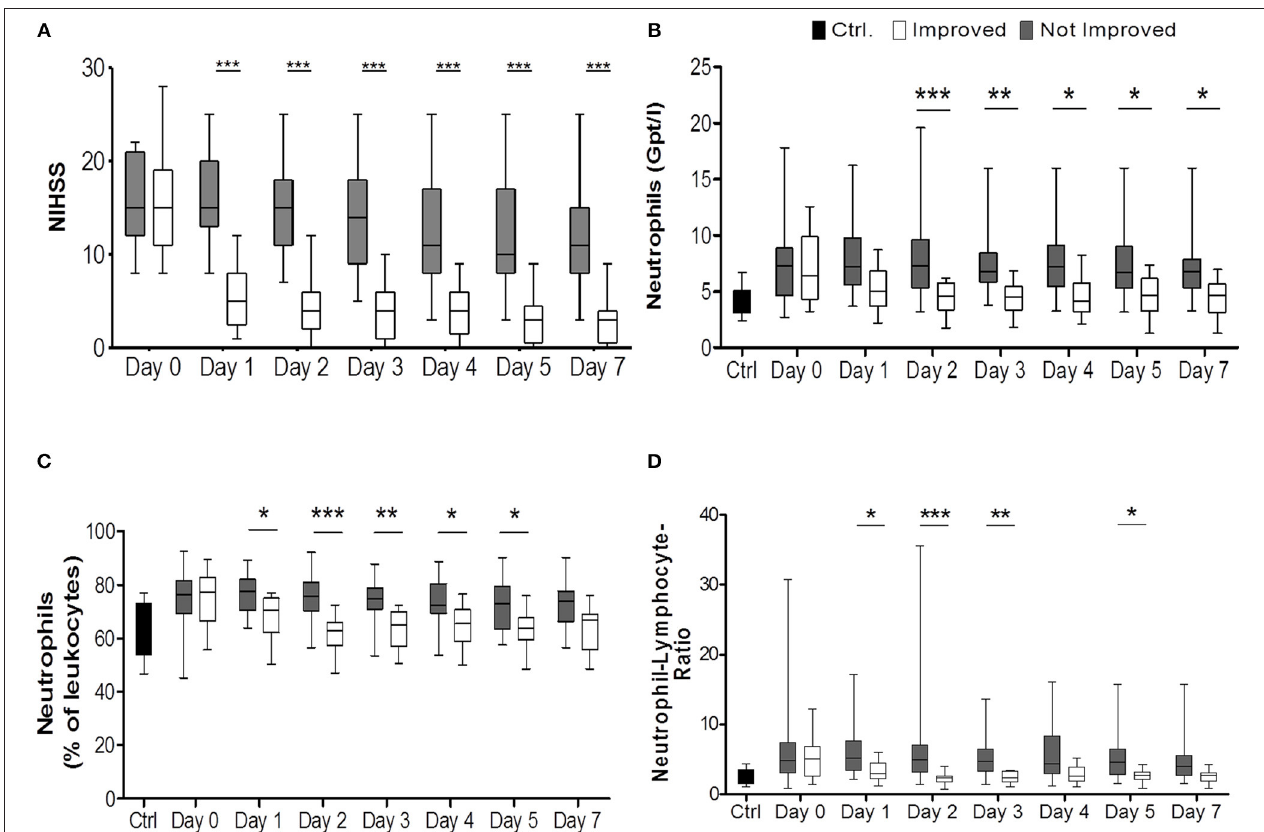
FIGURE 1 | Comparison of improved patients (white bars) vs. non-improved patients (gray bars) on the day of stroke unit admission (day 0), days 1, 2, 3, 4, 5, 7. National Institutes of Health Stroke Scale (NIHSS) served as surrogate marker for neurological improvement (A) (n imp = 13, n non − imp = 27). Healthy control patients are given in black bars. (B) illustrates the absolute numbers of neutrophils (Gpt/l) (n imp = 12, n non − imp = 25) while (C) shows relative numbers (%) (n imp = 12, n non − imp = 25). In (D) the lymphocyte-neutrophil ratio is shown (n imp = 12, n non − imp = 25). * p < 0.05; ** p < 0.01; *** p < 0.001; Box and whiskers (Min–Max) are